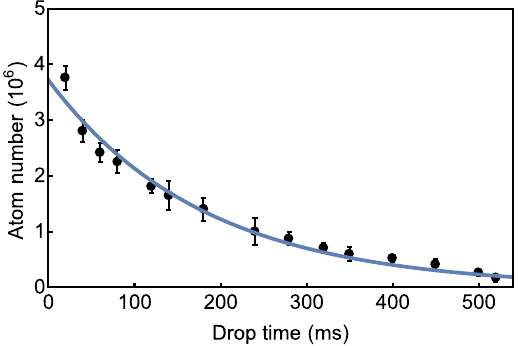
Figure 2. Atom number in the magnetic trap as a function of the ballistic drop time. The blue line indicates an exponential fit to determine a 1/e trap lifetime of 180 ± 10 ms.